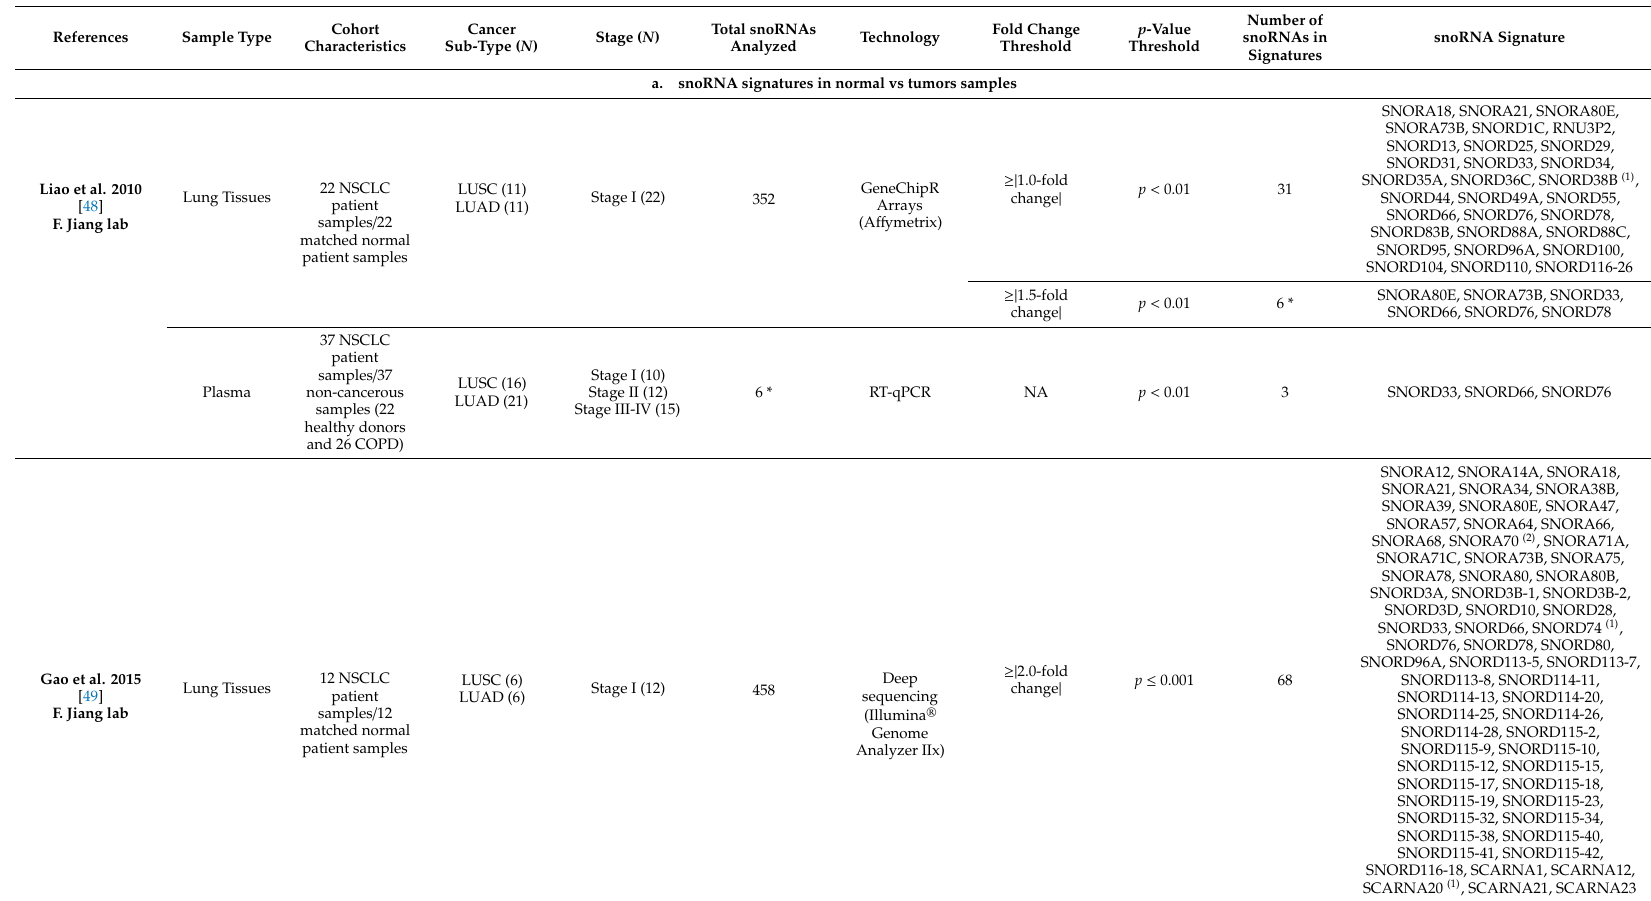
Table 1. snoRNA signatures identified in lung cancer